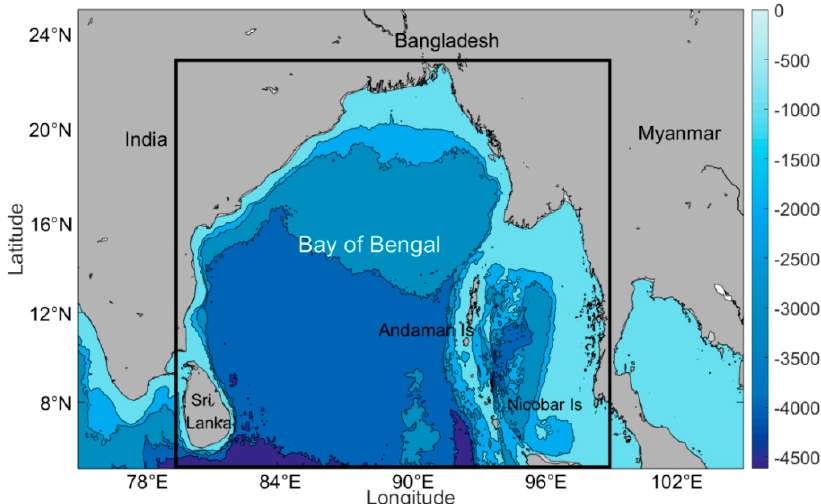
Figure 1. Bathymetry of the Bay of Bengal (BOB) derived from ETOPO1 (1 arc-minute global relief model of Earth’s surface that integrates land topography and ocean bathymetry). The black rectangle covers the study area (5–23°N, 79–99°E); (shaded: the ocean depth, unit: m).